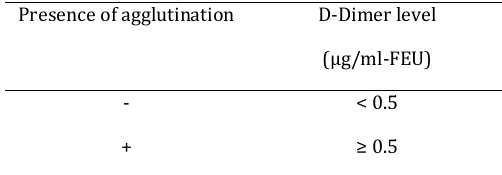
Table 1 . Positive and negative agglutination pattern